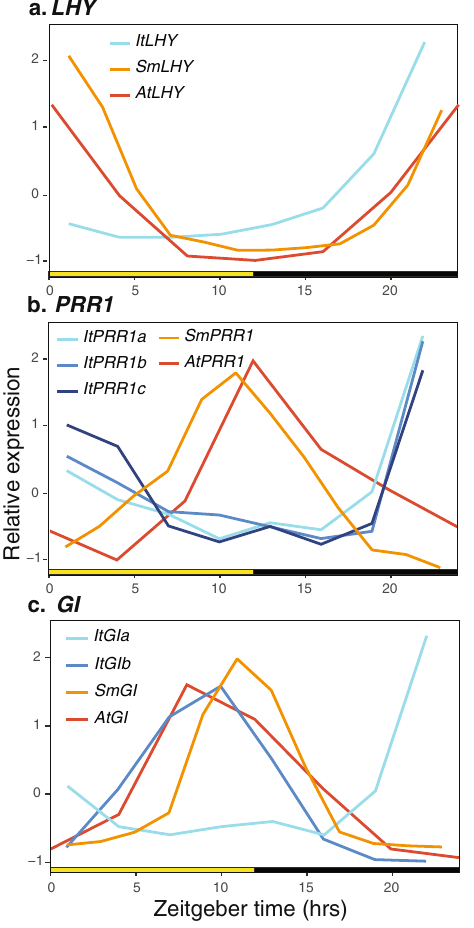
Fig. 6 Multiple CREs exhibit time-structured enrichment in I. taiwanensis . a , b Two telobox (TBX) containing motifs showed similar patterns to one another, both being enriched ingenes with peak expression at dusk. c Motif containing Evening Element (EE) was signi fi cantly enriched in genes with peak expression at mid-day. d A signi fi cantly enriched motif at mid-day. Day (yellow box); night (black box); Zeitgeber time (ZT) is the number of hours (h) after lights on (0 h). Shaded regions represent the standard deviation of log-transformed, FDR corrected, single-tailed p- values of component k-mers as calculated by ELEMENT 33 . Source data are provided as a Source Data